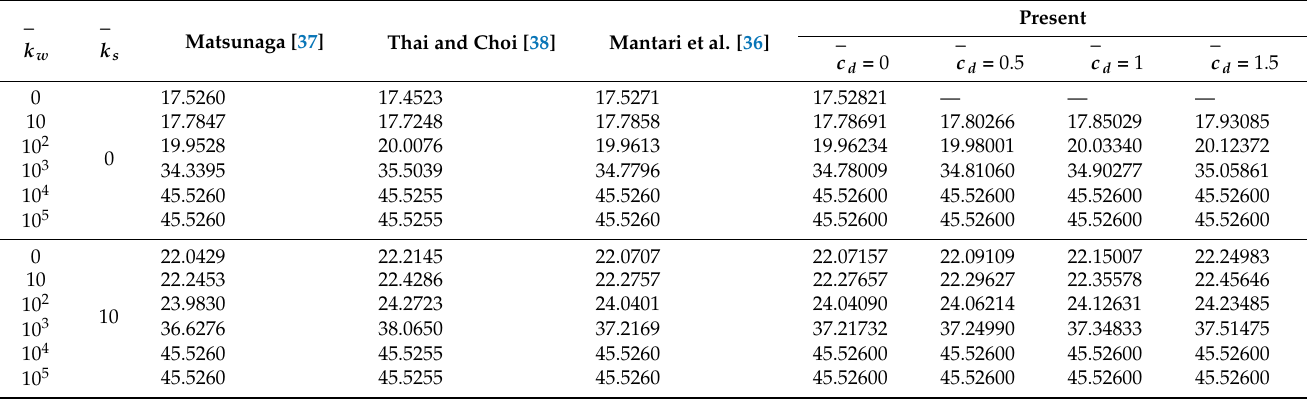
Table 2. Non-dimensional fundamental frequencies ω = ω a 2 resting on Visco-Winkler-Pasternak foundations ( a / h = 5, i = j = 1).